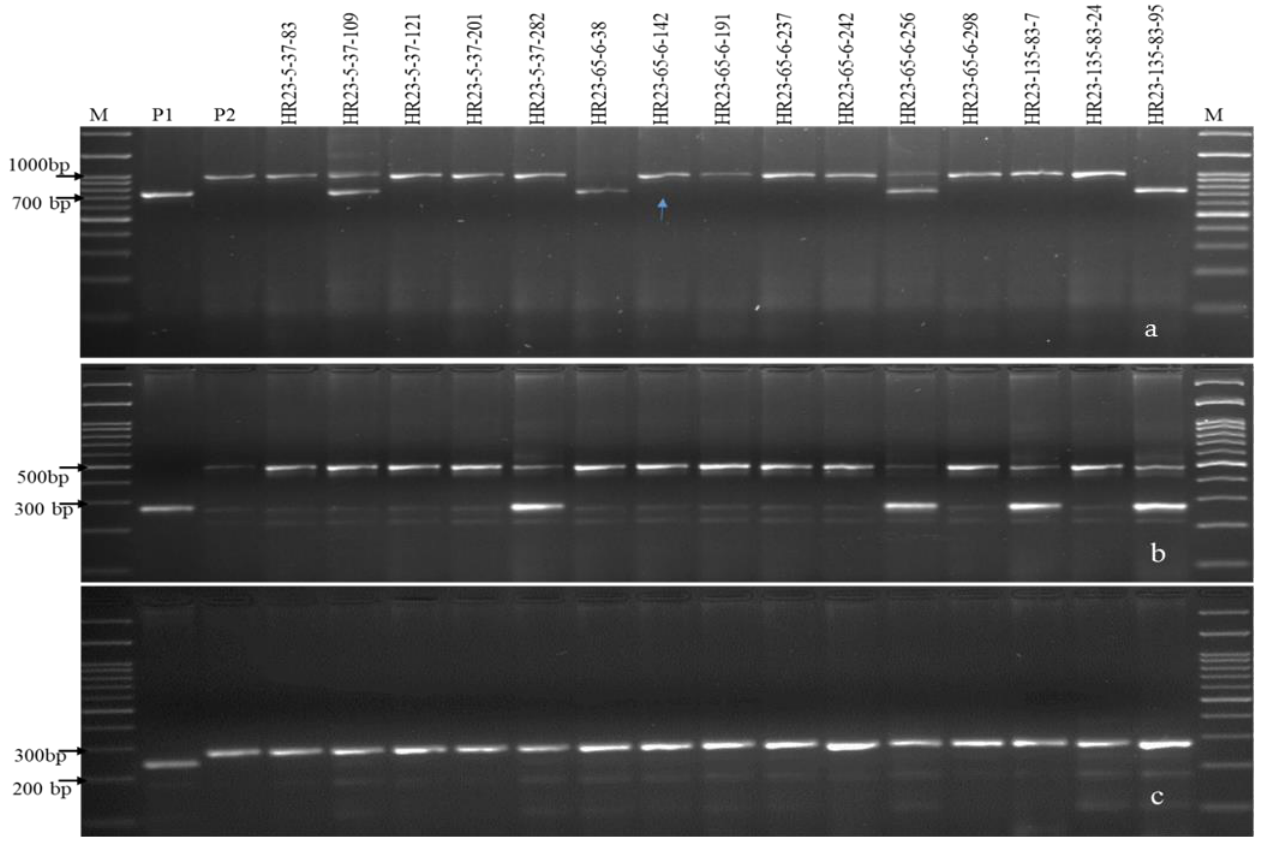
Figure 3. PCR amplification of bacterial blight resistant gene(s) in BC 2 F 2. ( a ) Amplicons of the Xa21 gene using pTA248 primer. ( b ) Amplicons of the xal3 gene using xal3 prom primer. ( c ) Amplicons of the xa5 gene using RM122 primer; M, marker; P1, RP (HUR 917); P2, donor parent (IRBB66), Lanes 4–18 represent NILs, vertical arrows indicate positive plant homozygous/heterozygous for targeted